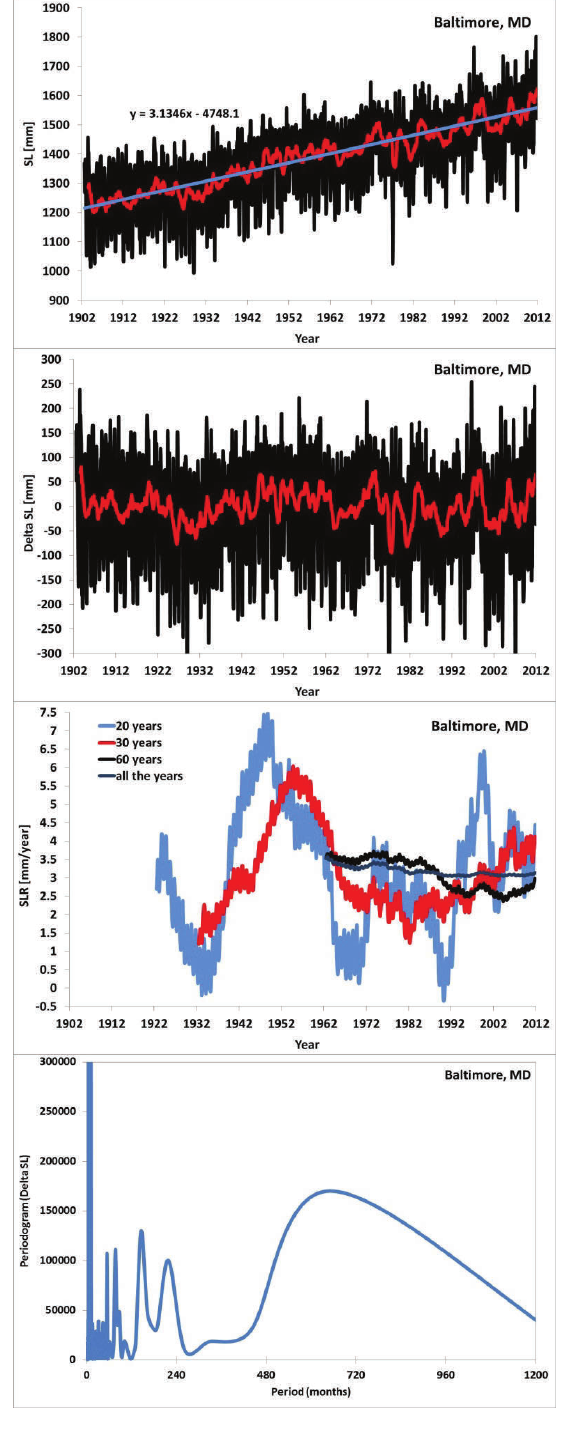
Figure 2. Top to bottom: monthly averages, departures vs. the linear trend, time series of sea level rises computed with different time windows and periodogram of the de- partures about the linear trend (pictures from [8, 9]) and last three decades of sea level rises and accelerations for Baltimore, MD. The sea levels are clearly oscillating and not accelerating. (data from